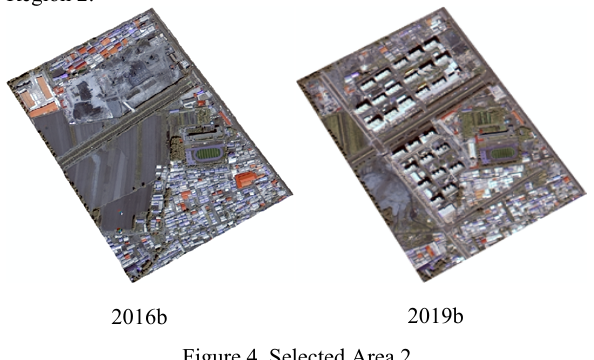
Figure 4. Selected Area 2